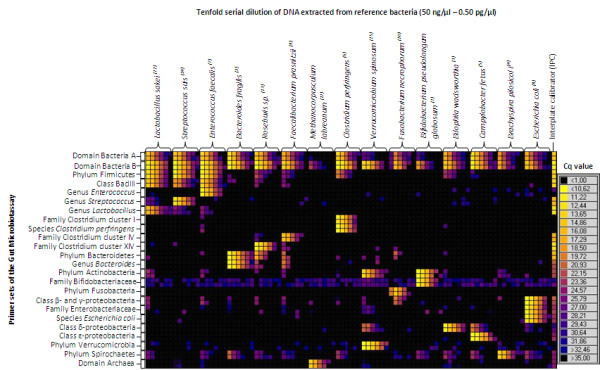
Heatmap generated by the Fluidigm Real-Time PCR Analysis program from raw Cq data. At the top horizontal: Tenfold serial dilutions of DNA (ranging from 50 ng/μl down to 0.5 pg/μl) extracted from 15 different reference bacteria. Raised numbers in parentheses represent the respective numbers given to each reference bacterium in Table 1. These were used to test the specificity and sensitivity of the primer sets included in the Gut Microbiotassay, listed vertically on the left. Primers were run in duplicates. On the right: a colour scale depicting the respective Cq values (the software uses commas instead of points as decimal separator for Cq values).